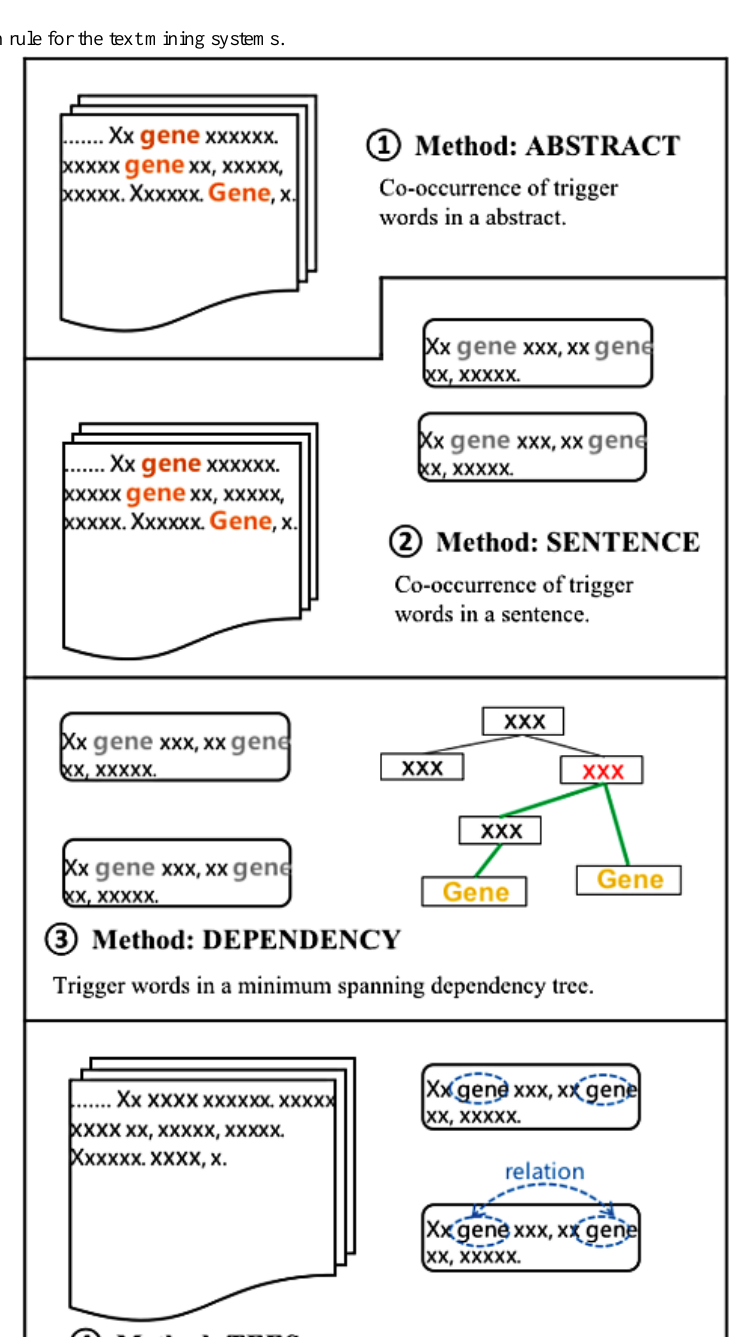
Figure 2. Gene pair extraction rule for the text mining